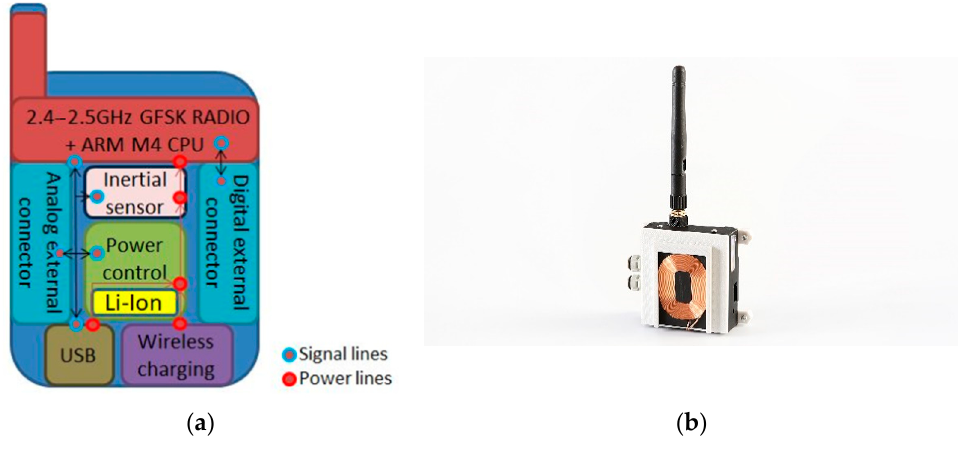
Figure 5. BB2 final design: system structure ( a ), real device ( b